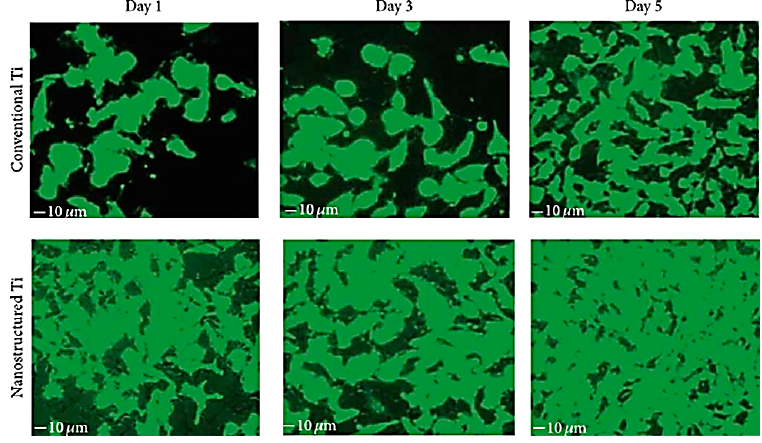
Figure 7. Fluorescent microscopy images of endothelial cell proliferation on nanostructured Ti compared to conventional Ti. Reproduced with permission from [129].